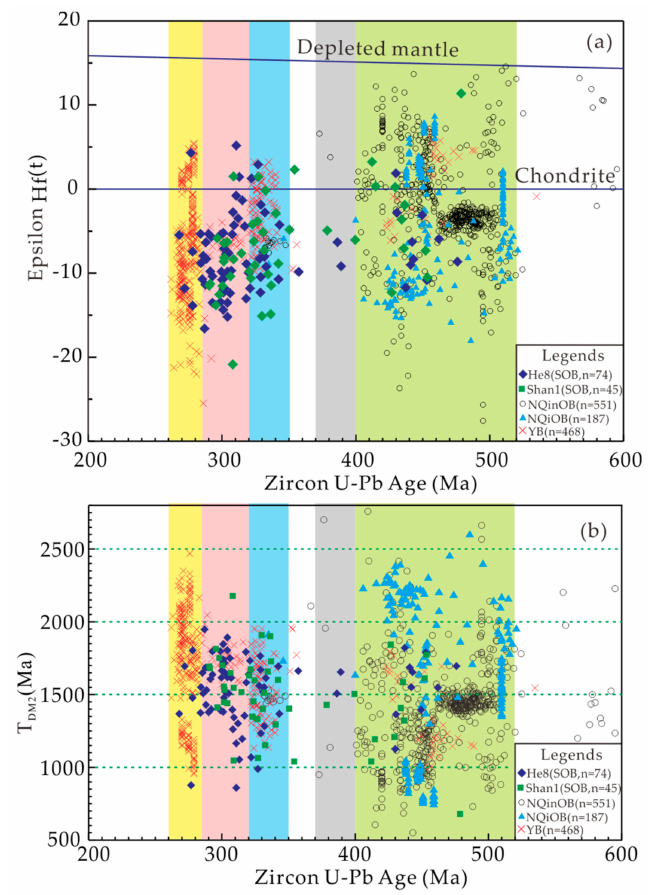
Figure 9. ε Hf (t) values vs. U-Pb ages ( a ) and T DM2 values vs. U-Pb ages ( b ). The yellow, pink, blue, gray and green bars show the age groups of 285–260 Ma, 320–285 Ma, 350–320 Ma, 400–370 Ma and 520–400 Ma, respectively. The Hf isotope evolution line for Depleted Mantle follows [46]. The Lu-Hf isotopic compositions of the North Qinling Orogenic Belt (NQinOB) are from [60,61,64–67], the North Qilian Orogenic Belt (NQiOB) from [94–96,136], and the Yinshan Block (YB) from